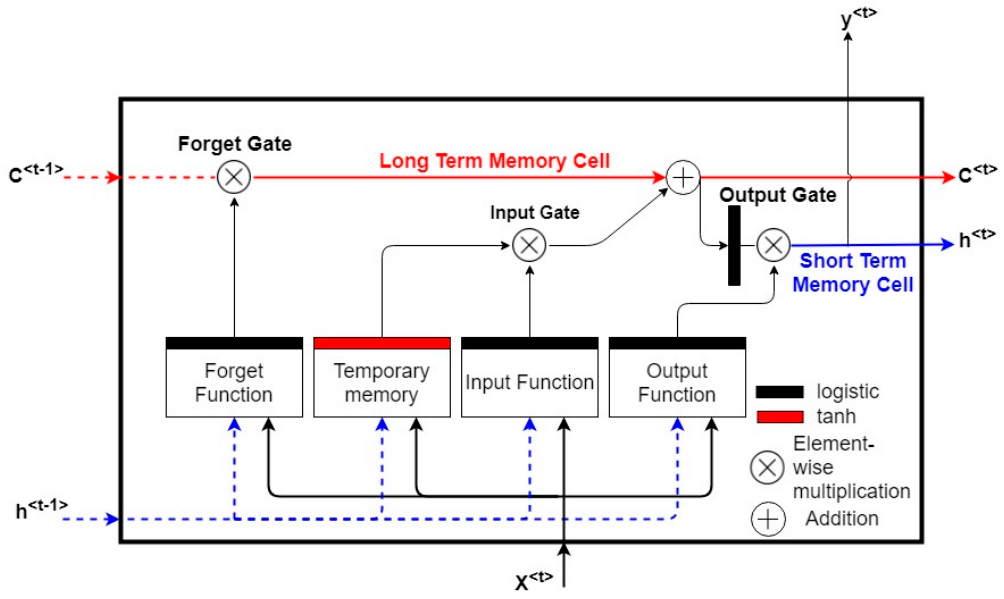
Figure 3. The long short-term memory (LSTM) network memory block.